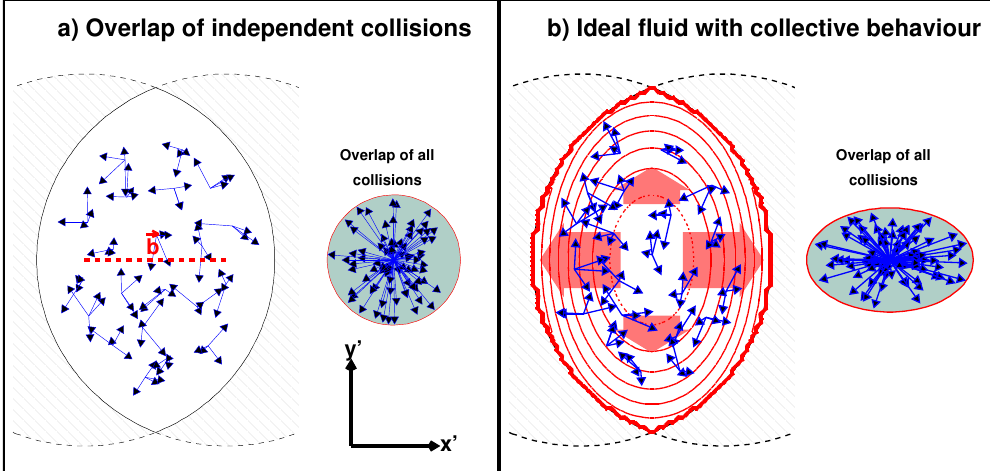
Figure 6. Schematic view of the development of collective phenomena correlated with the initial spatial anisotropy, in the case ( a ) or not ( b ) of a strongly interacting